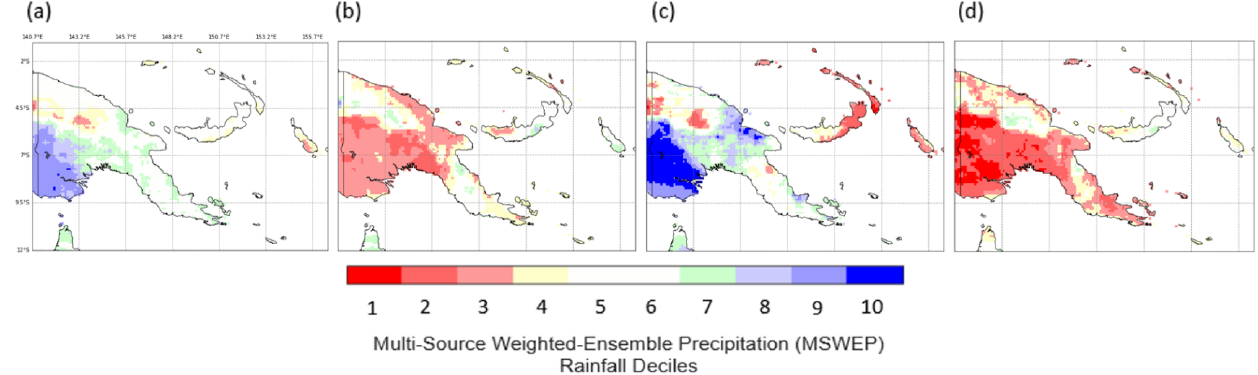
Figure 2. Multi-Source Weighted-Ensemble Precipitation (MSWEP) rainfall deciles in response to various climate drivers: (a) negative IOD phase (during 1981, 1989, 1992, 1996, 1998, 2010, 2014, and 2016 years), (b) positive IOD phase (during 1982, 1983, 1994, 1997, 2006, 2012, 2015, and 2019 years), (c) negative IOD phase and La Niña ENSO phase (during 1989, 1998, and 2010 years) and (d) positive IOD phase and El Niño ENSO phase (during 1982, 1994, 1997, 2006, and 2015 years). Deciles are compared to a 1980–2020 base period. Figure adapted from Bhardwaj et al.